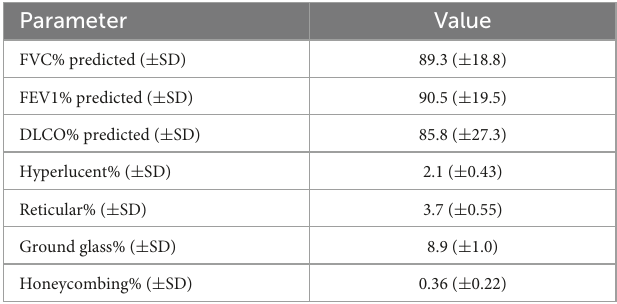
TABLE 2 Functional and radiographic findings 3 months following